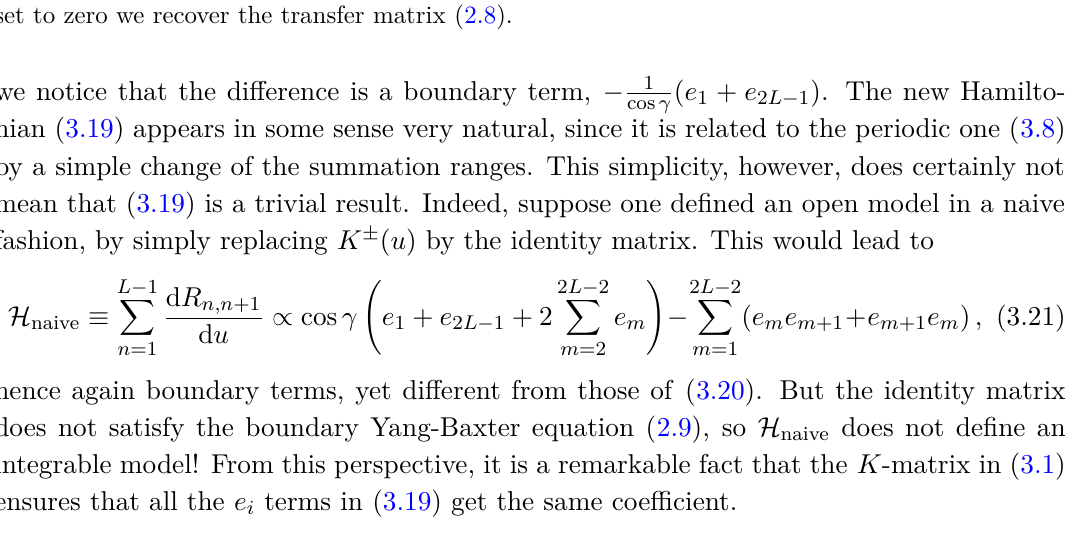
Figure 4 . Geometrical interpretation of the transfer matrix (3.22). When the parameters ω i are set to zero we recover the transfer matrix